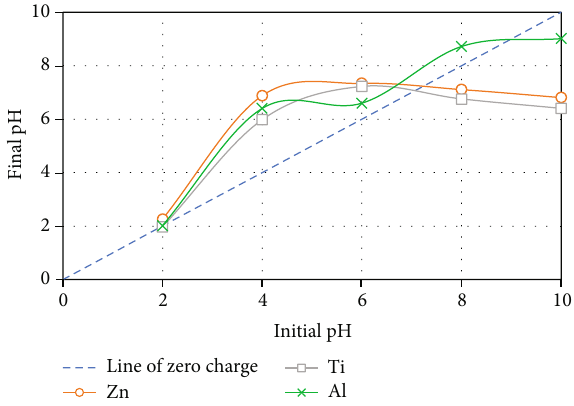
Figure 1: pH drift method for all